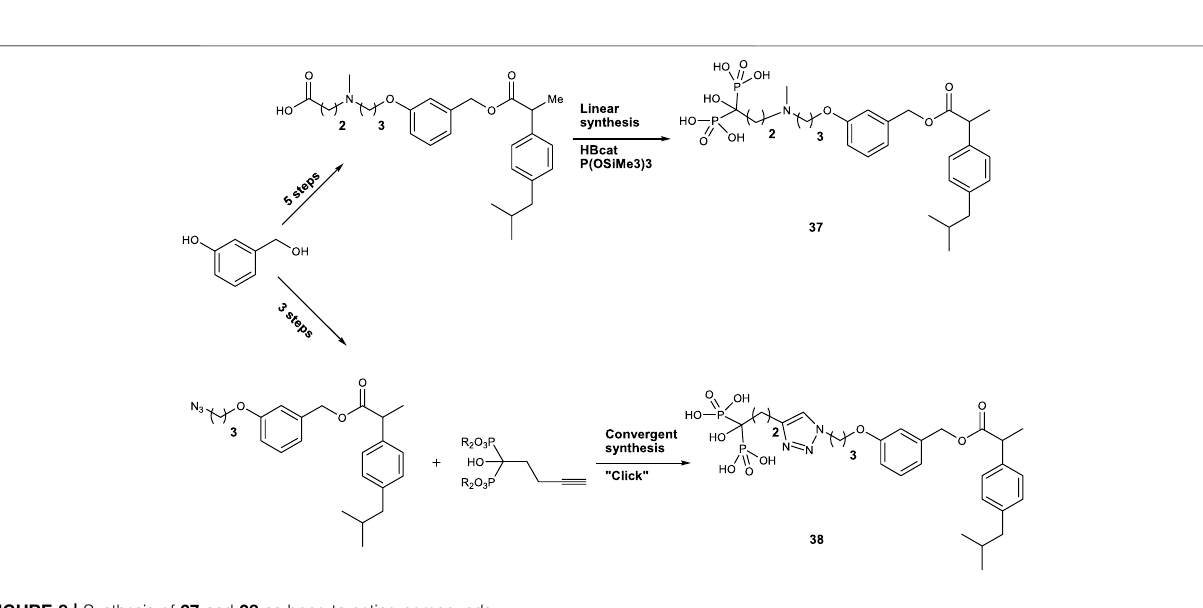
Frontiers in Chemistry |